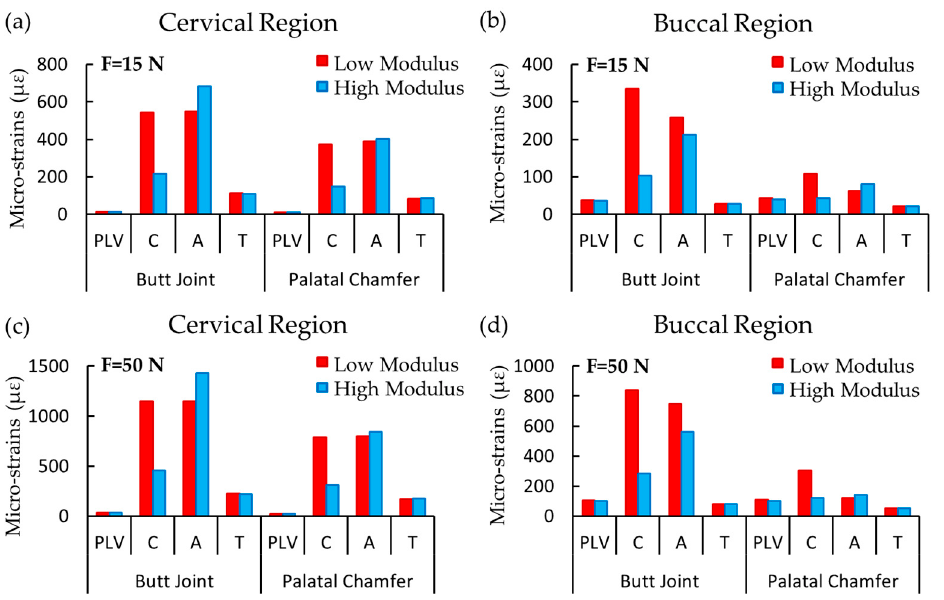
Figure 8. The average strain values in the porcelain laminate veneer (PLV), resin cement (C), adhesive layer (A), and prepared tooth (T) ( a ) in cervical region, ( b ) in buccal region due to the 15 N force (F) of protrusive movement, ( c ) in cervical region and ( d ) in buccal region due to 50 N force of tearing function.